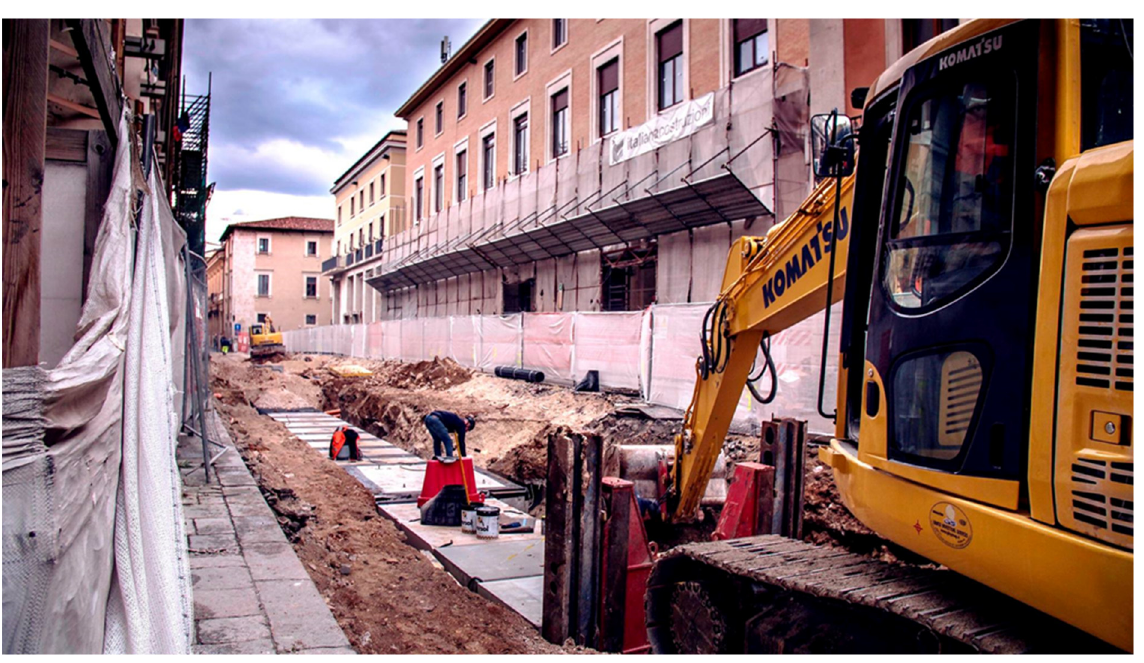
Figure 2. Positioning and assembly of the prefabricated elements to host the utility networks along Corso Vittorio Emanuele in L’Aquila.